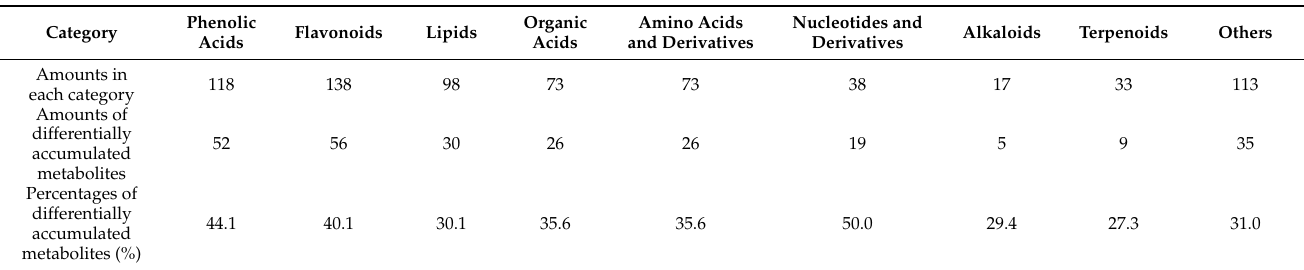
Table 1. Classification of 258